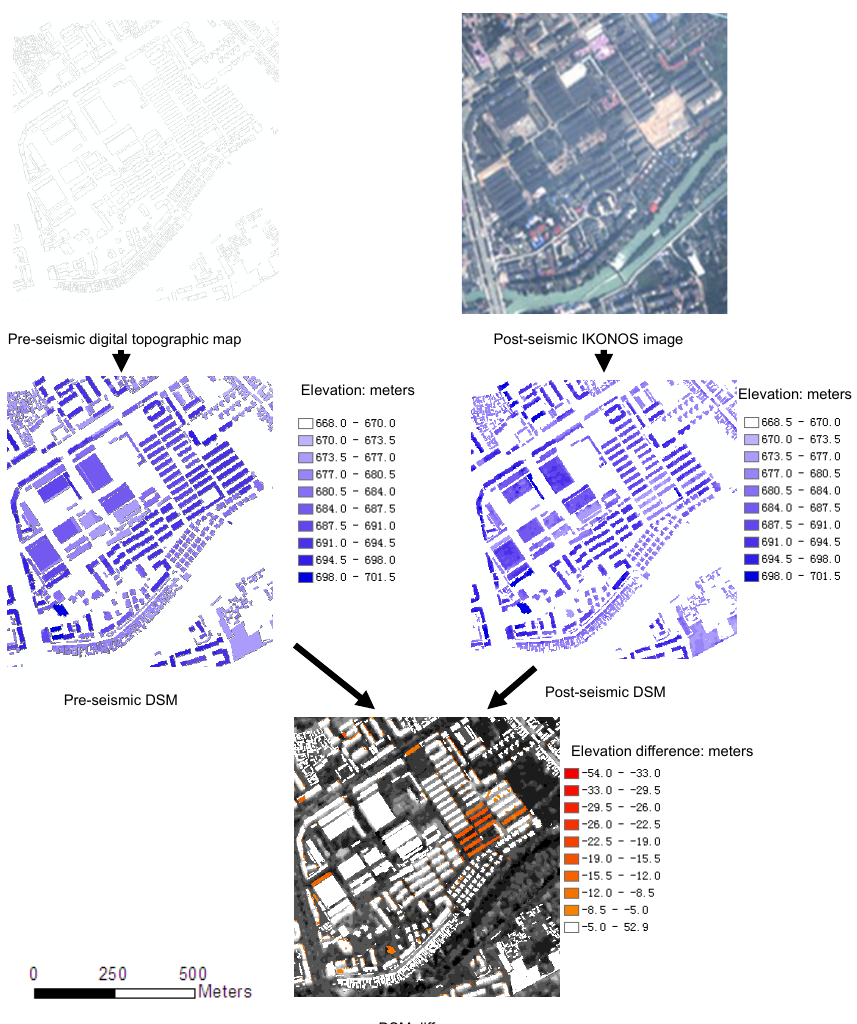
Figure 4. Three-dimensional detection of building damage by using DSM Fig. 4 Three-dimensional detection of building damage by using DSM difference